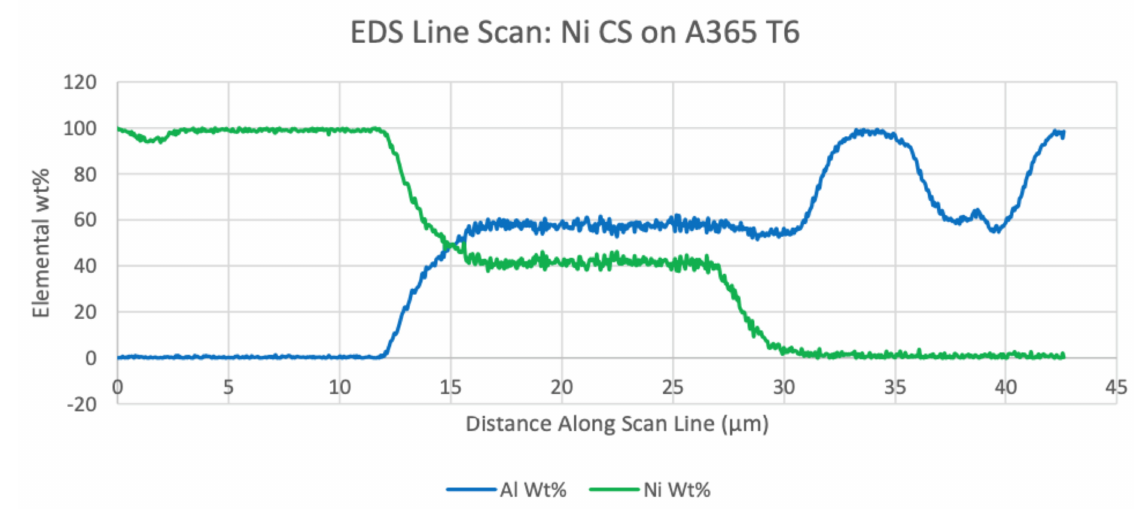
Figure 8. Presentation of the EDS line scan recorded for the Ni CGDS coated HPDC A365 substrate system in the thermally postprocessed